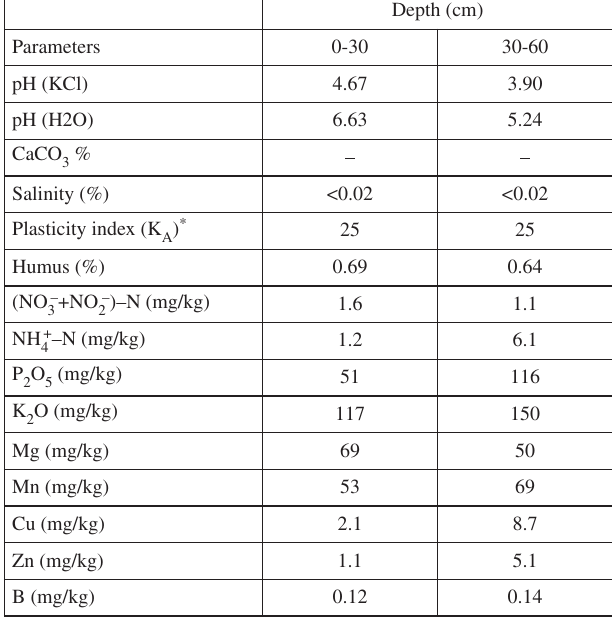
*Plasticity index according to Arany is a soil parameter connection with clay content of soil, using in